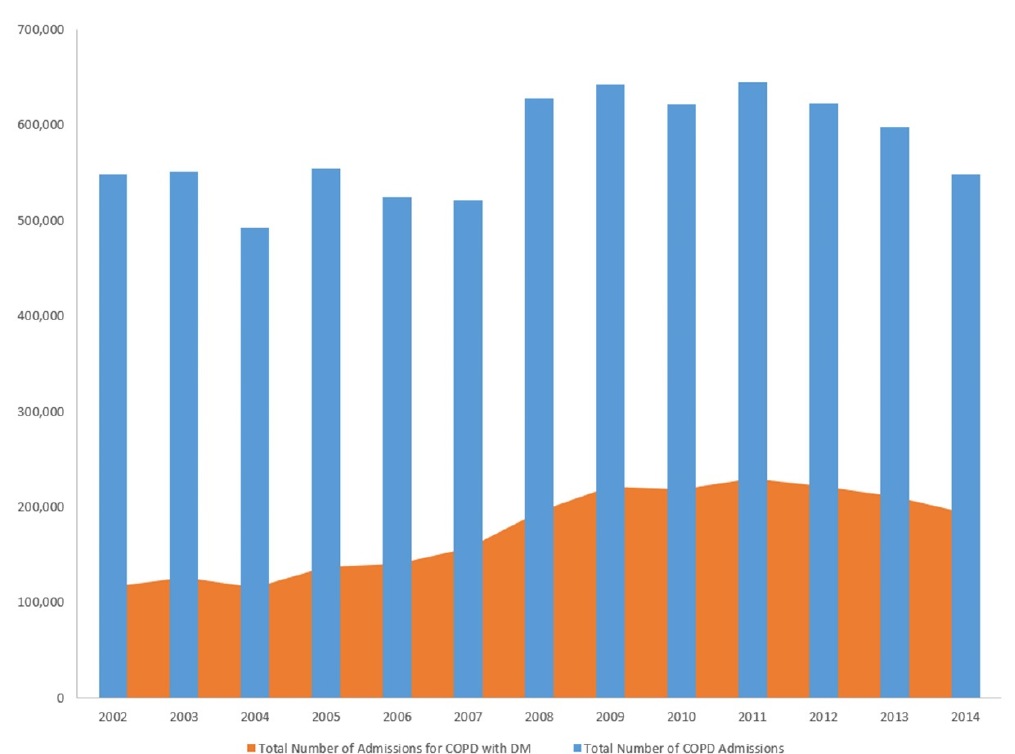
Figure 1. Trends of hospitalization for chronic obstructive pulmonary disease (COPD) and diabe- tes mellitus (DM) in COPD 2005–2014. in COPD